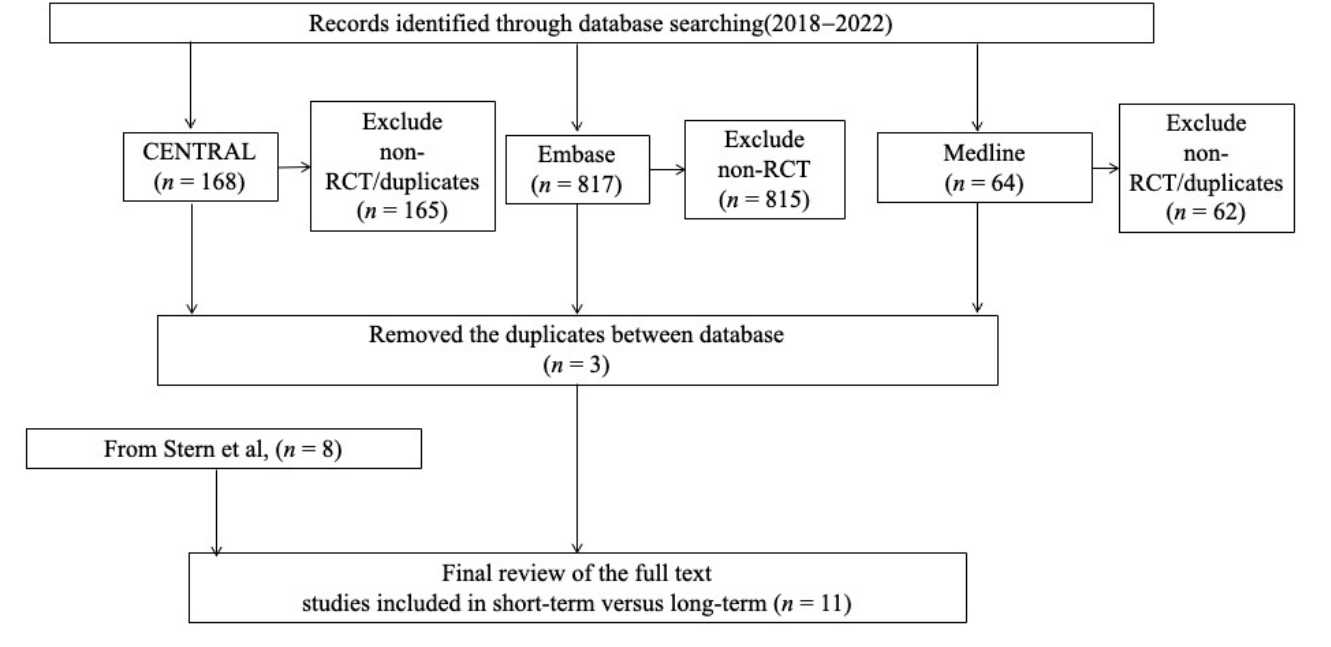
Figure 1. Simple identification process for eligible studies by two independent reviewers, with reference to the previous systematic review by Stern et al. [13].